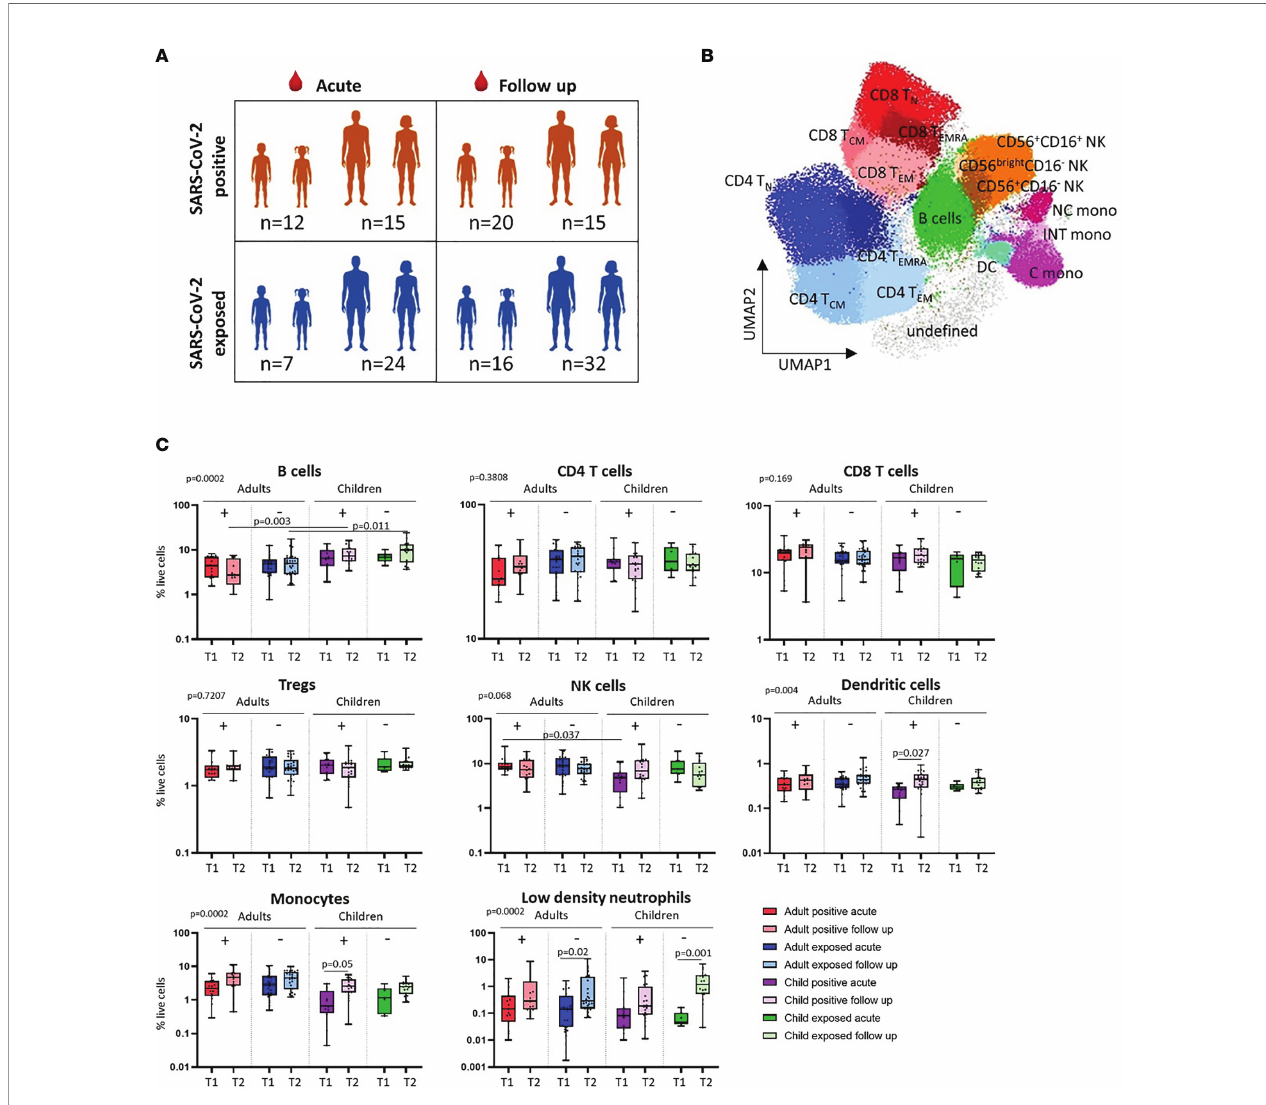
FIGURE 1 | Cross-sectional analysis of immune cell pro fi les in SARS-CoV-2 positive and SARS-CoV-2 exposed children and adults. (A) Blood samples were collected during infection/exposure (acute) or 4-9 weeks following (follow up) from SARS-CoV-2 positive participants (n=12 child acute, n=20 child follow up, n=15 adult acute, n=15 adult follow up) and SARS-CoV-2 exposed participants (n=7 child acute, n=16 child follow up, n=24 adult acute, n=32 adult follow up). (B) Blood samples were processed into PBMC and analysed on the day of collection by fl ow cytometry. Unsupervised analysis of fl ow cytometry data revealed 17 clusters associated with CD4 T cells, CD8 T cells, NK cells, monocytes, dendritic cells, B cells and their cell subsets. (C) Comparison of the proportions of major cell populations in each clinical group (T1 – acute samples, T2 – follow up samples). P values by Kruskal-Wallis rank sum test and Dunn ’ s multiple comparison testing. FDR-adjusted P-values are reported. Boxplots show the medians, the 1 st and 3 rd quartile as well as the smallest and largest values as